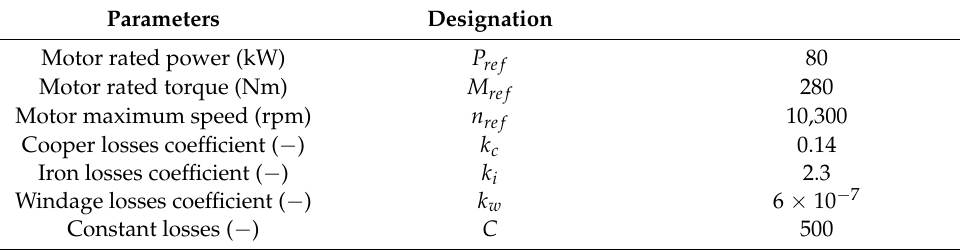
Table 1. Reference traction motor